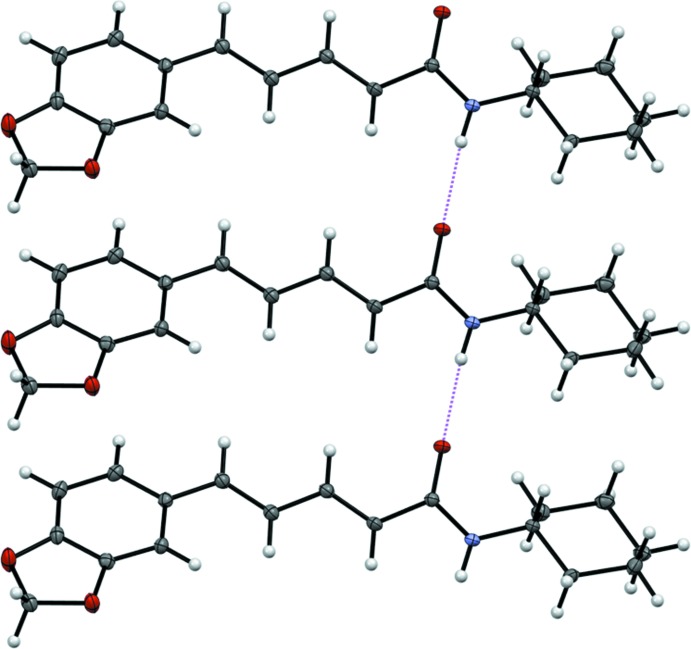
A view along the c-axis direction of the crystal packing of (I). The N—H⋯O hydrogen bonds are drawn as dashed lines.